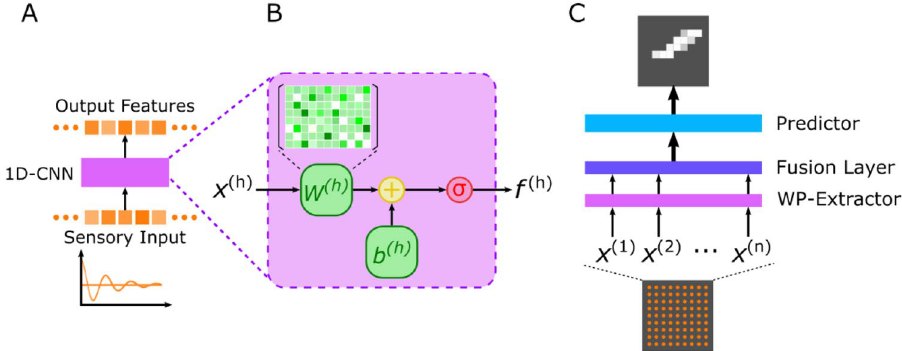
Figure 2. Conceptual explanation of the proposed crack detection model with 1D-CNN detector. ( A ) Diagram of a 1D-CNN that transforms a discretized wave input and produces a discrete feature sequence. ( B ) Internal STRU CTU RE of a 1D-CNN layer, consisting of a trainable weight W ( represented by σ . C. Diagram of the complete structure of the proposed